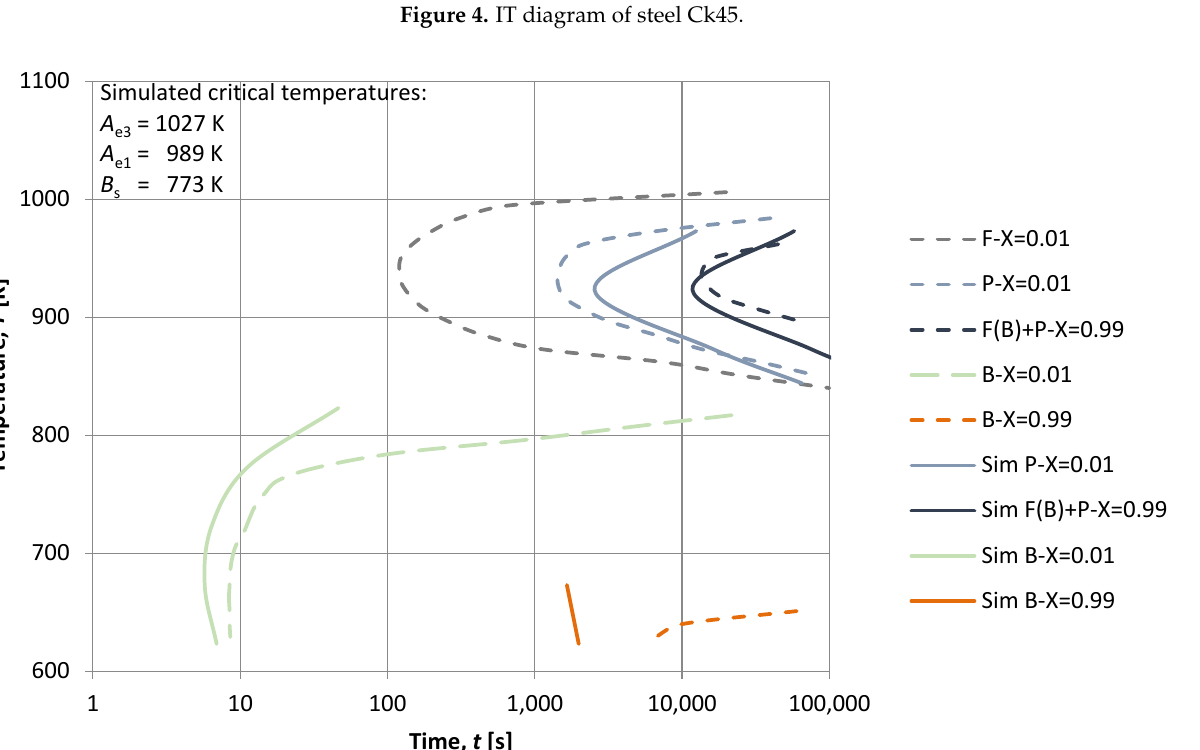
Figure 5. IT diagram of steel 28NiCrMo74.